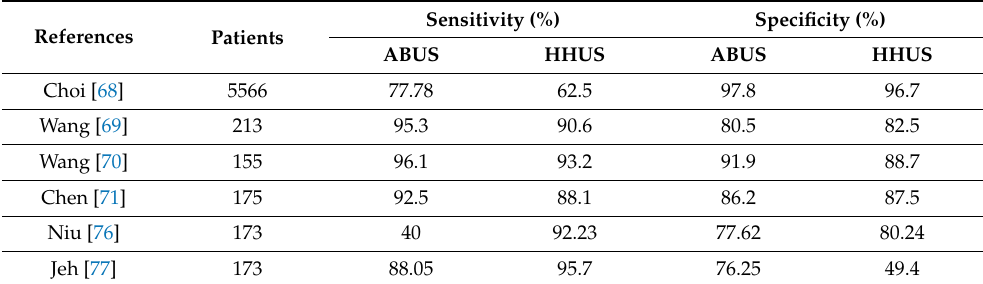
Table 3. Comparison of diagnostic metrics of ABUS and